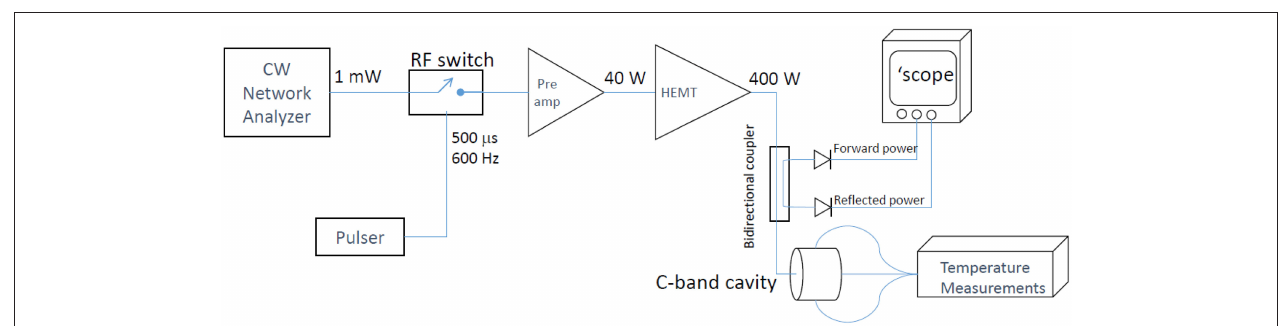
FIGURE 6 | Schematic of the HEMT RF accelerator performance